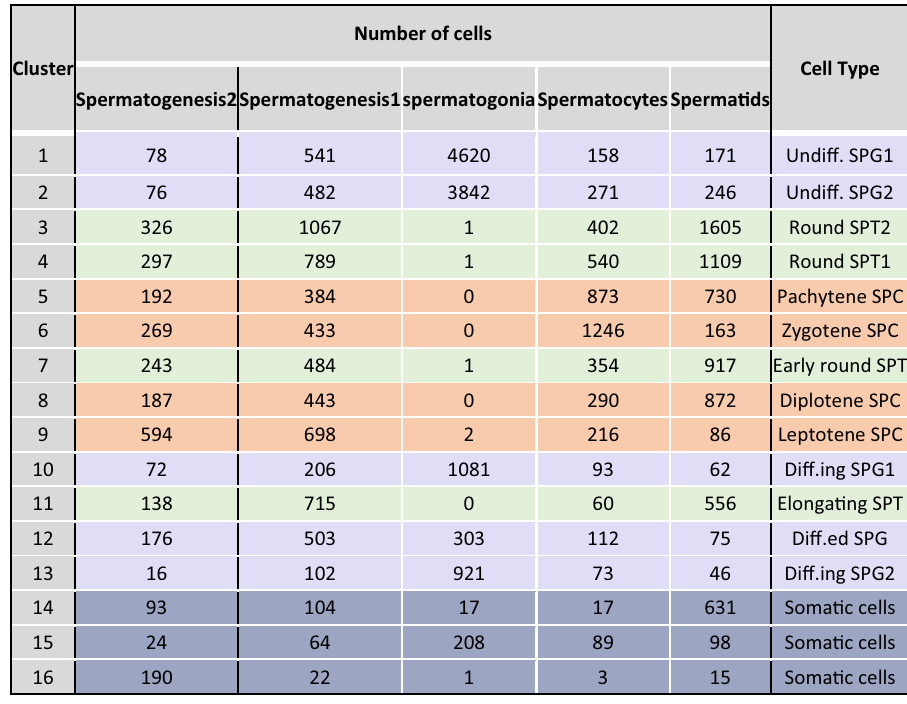
Table 1. Characteristics of clusters. The numbers of cells for each dataset, cluster, and cell type assignment for each cluster were specified. The rows are colored based on the cell